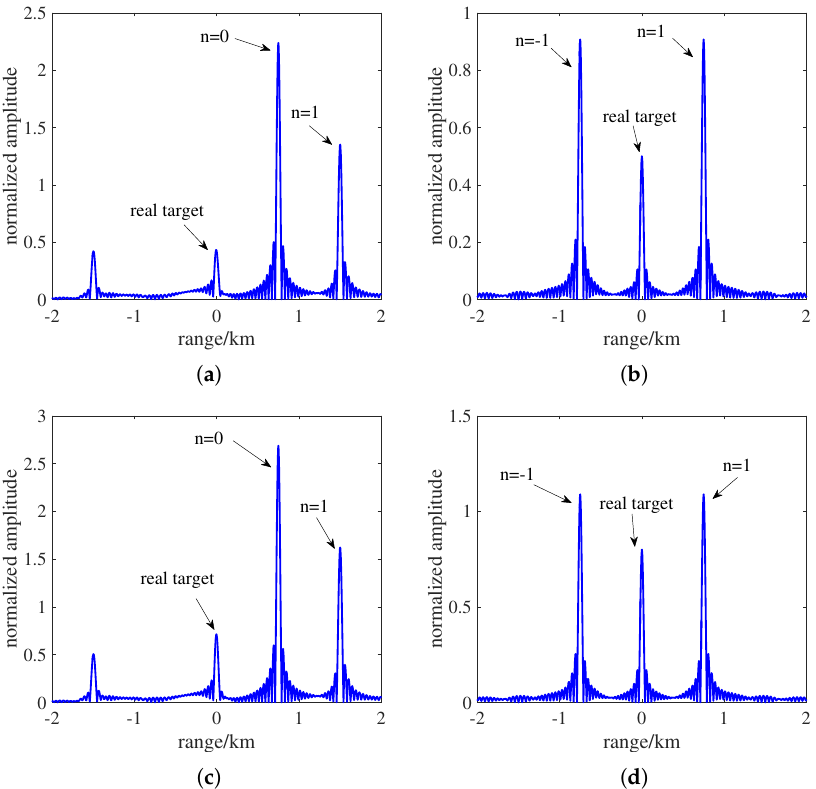
Figure 5. Target echo cancellation result with amplitude mismatch ( f s = 200 kHz). ( a ) Method 1 ( γ = 50%). ( b ) Method 2 ( γ = 50%). ( c ) Method 1 ( γ = 80%). ( d ) Method 2 ( γ = 80%).